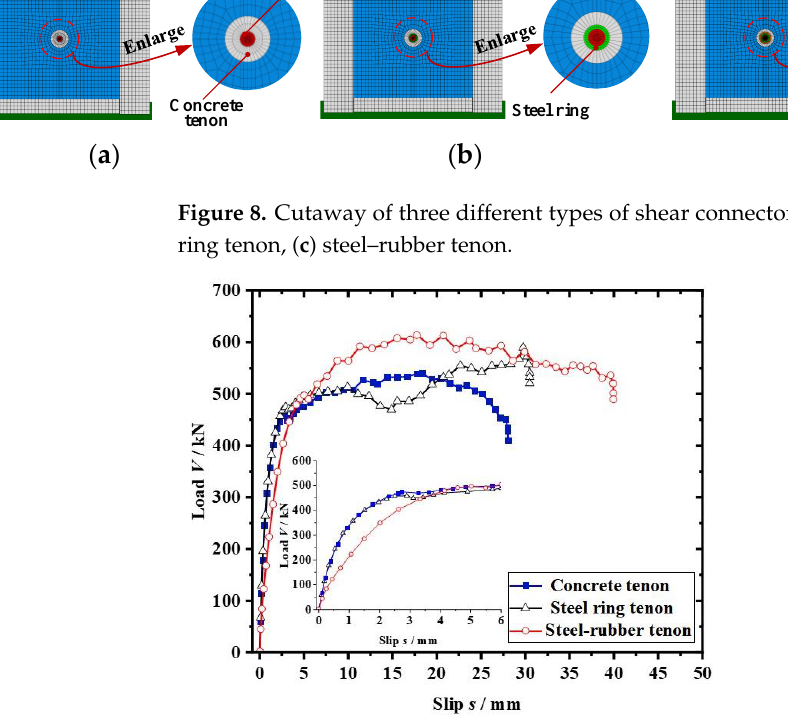
Figure 9. Three different types of load – slip curves.